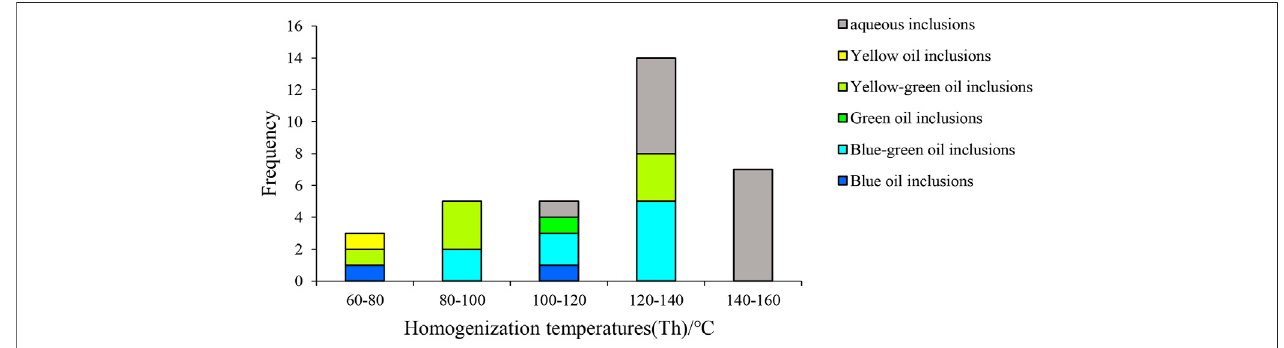
FIGURE 4 | Histograms of homogenization temperatures for oil inclusions with various colors and coeval aqueous inclusions in the FGSR reservoir.